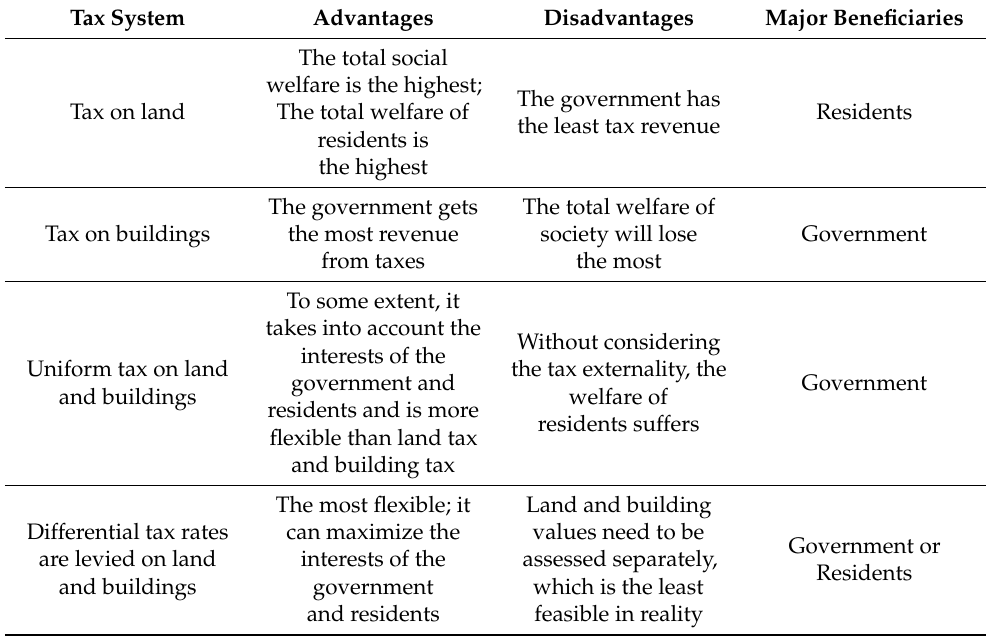
Table 2. Comparison of advantages and disadvantages of different real-estate tax systems (under land public